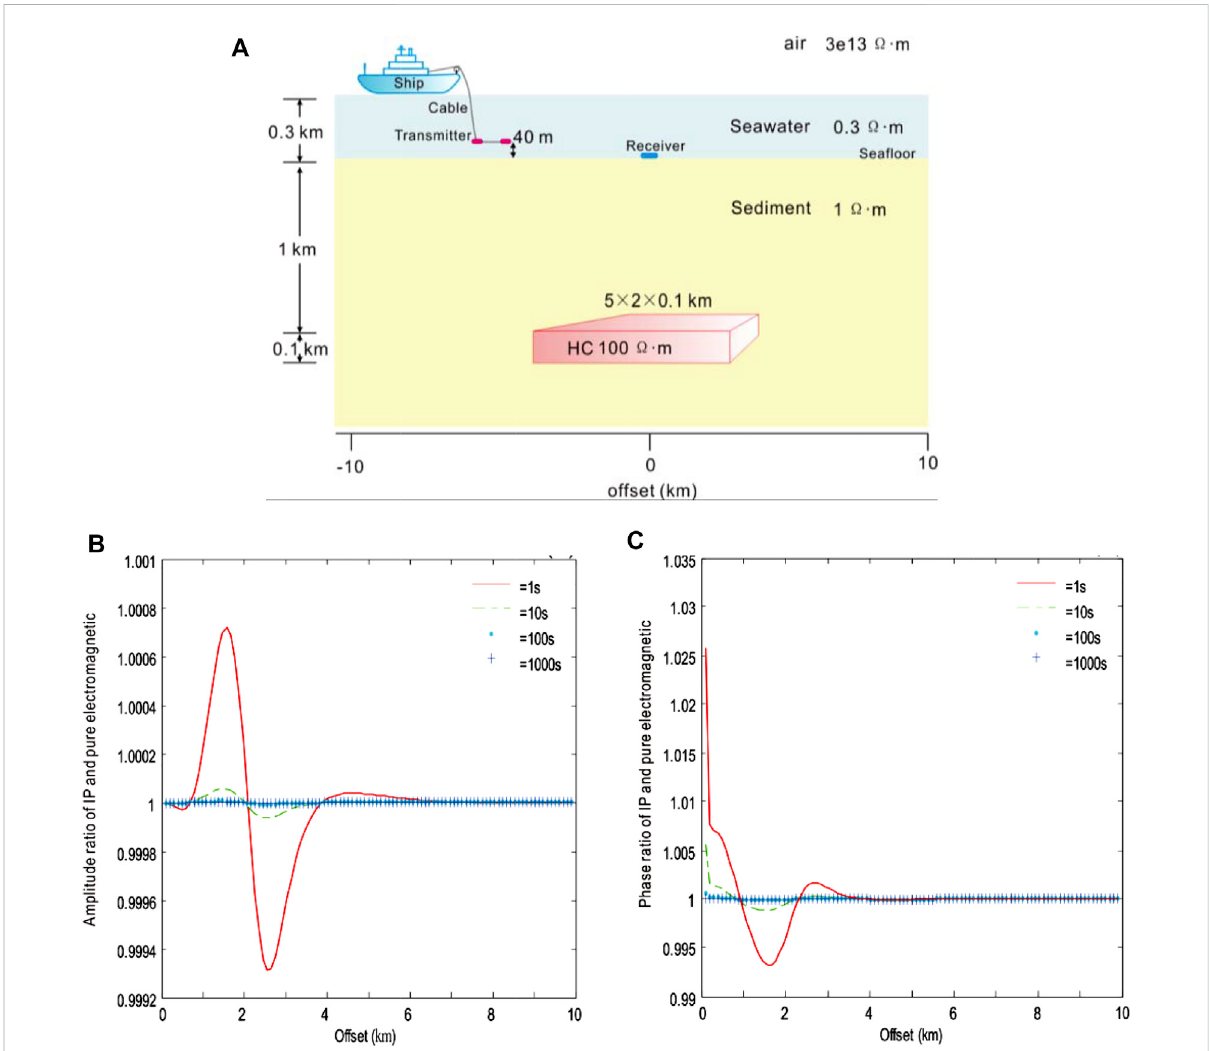
FIGURE 9 AmplitudeandphaseratioofCSEMwiththeIPandpureelectromagnetic fi eldtotheDiasmodelofvarioustimeconstants τ =1(red),10(green), 100 (blue), and 1,000 (light blue), respectively. (A) Geoelectric model of submarine hydrocarbons with ion-induced polarization in the 3D marine CSEM, (B) the ratio of amplitude, and (C) the ratio of